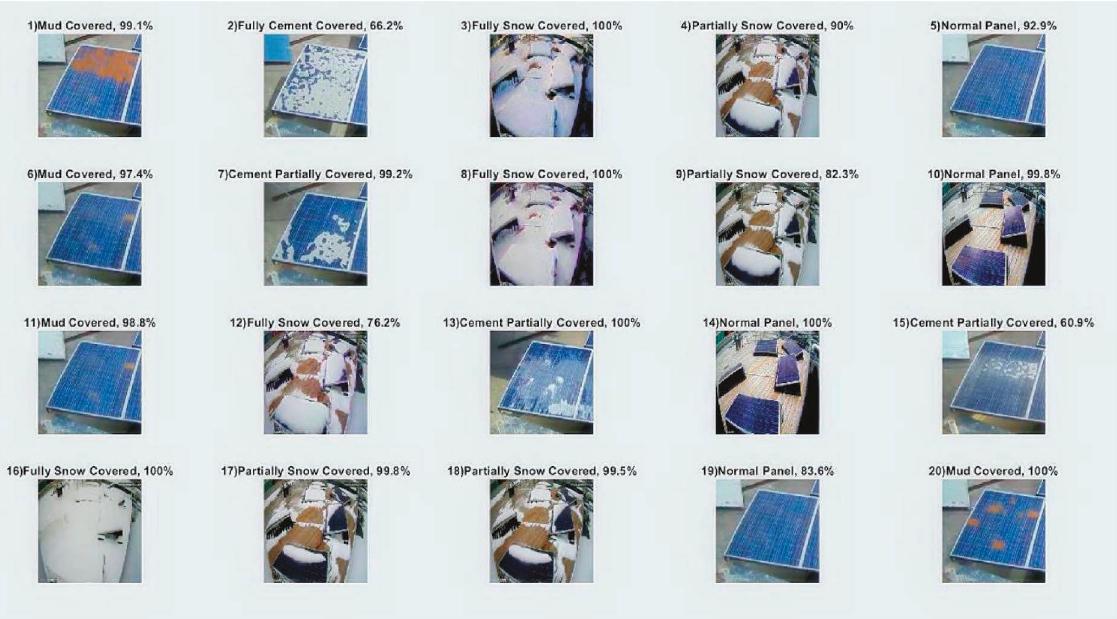
Figure 17: Fault classified by AlexNet with testing